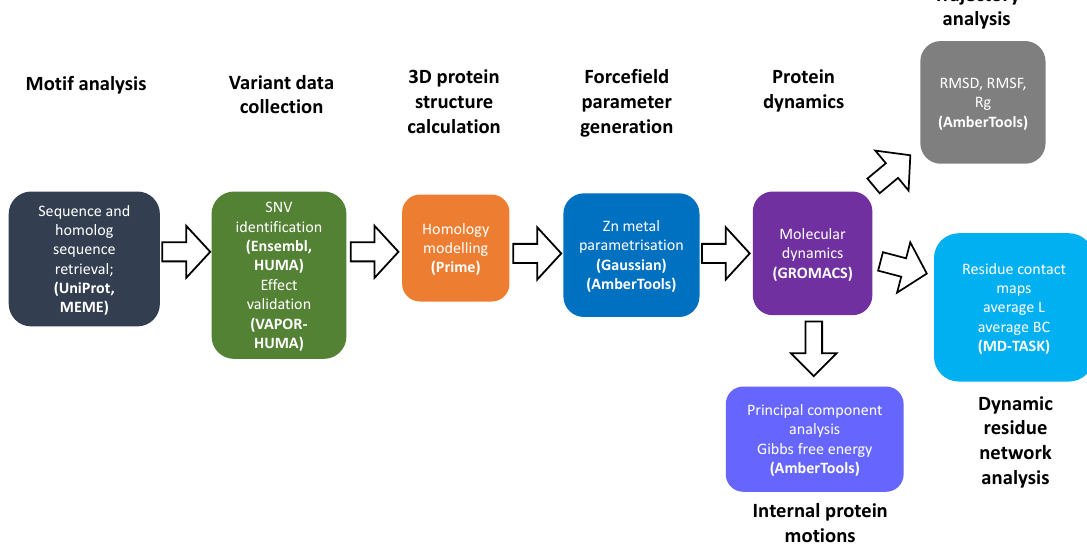
Figure 11. Flow chart of methodology used in analysis of the effects SNVs on CA-II structure and